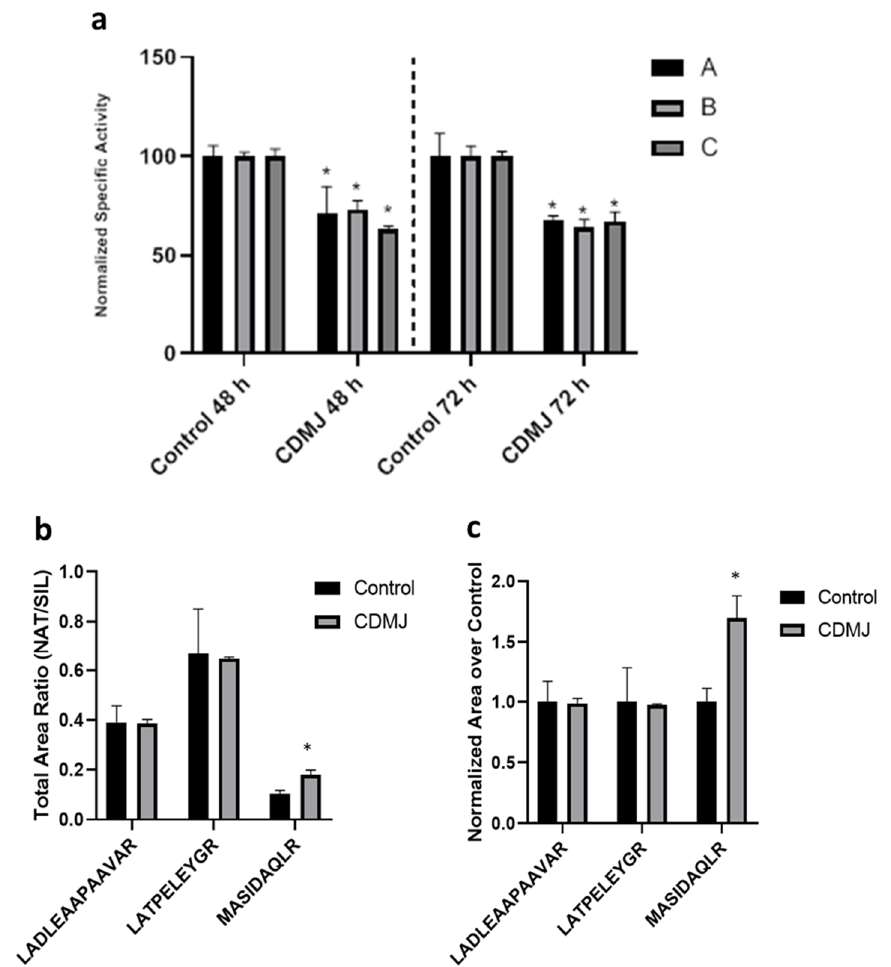
Figure 2. Determination of total extractable activity and changes in the phosphorylation levels of PPC in response to elicitation with the combined treatment CDMJ. ( a ) Specific activity (U/mg) of PPC in native extracts of grapevine Gamay cell cultures upon elicitation with CDMJ at 48 and 72 h. Each bar represents the result of one biological replicate (A, B, C) with triplicate assays normalized to its respective control. One biological replicate is an independent culture flask. ( b , c ) Relative abundance of PPC surrogate tryptic peptides in native extracts of grapevine Gamay cell cultures upon elicitation with CDMJ at 72 h. MASIDAQLR contains the conserved PPCK phosphorylation target Ser residue [14]. The two other peptides serve as internal reference. Peptides were recovered from an excised 110 kDa SDS-PAGE band digested in-gel with trypsin and spiked with a mixture of the SIL version of the targeted peptides. Each bar is the average of three biological replicates. ( b ): Abundance of each native peptide relative to its SIL version measured as the peak area ratio acquired in MRM mode. Differences between peptides can be due to the inaccuracy in quantification of the SIL peptides of “SpikeTidesTM L” quality. ( c ): To highlight the differences in the abundance of peptides between the control and CDMJ, data were normalized versus the control condition for each peptide. Significance of differences between control and CDMJ were determined using Student´s t -test (* p < 0.05).